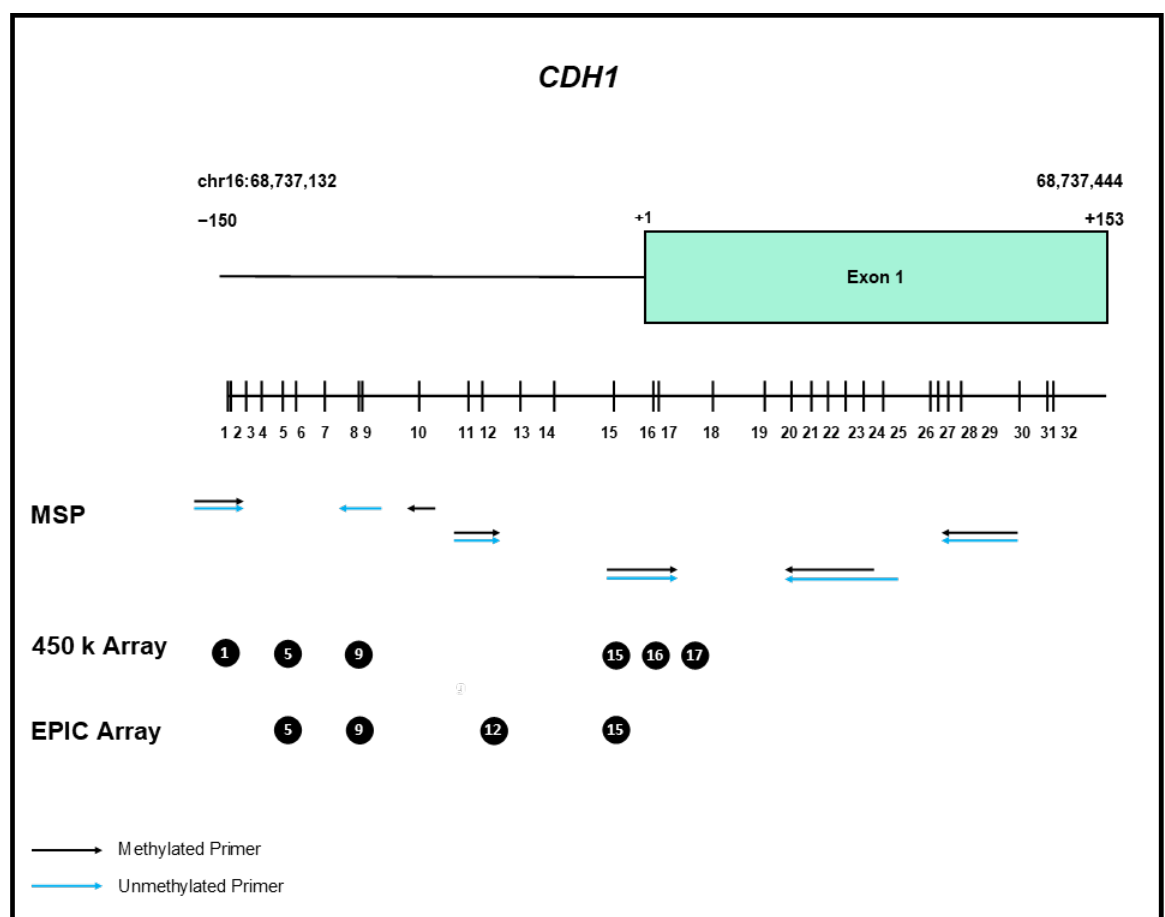
Figure 2. Schematic overview of the CpG islands encompassing the 5′ end of the CDH1 gene. The individual CpG dinucleotides are represented by vertical bars, representing the distribution within the genomic sequence surrounding the start point of transcription (+1). The position of the primers for various MSP and qMSP assays are indicated by arrows, the CpG dinucleotides represented on the 450 k and EPIC array are indicated by circles.